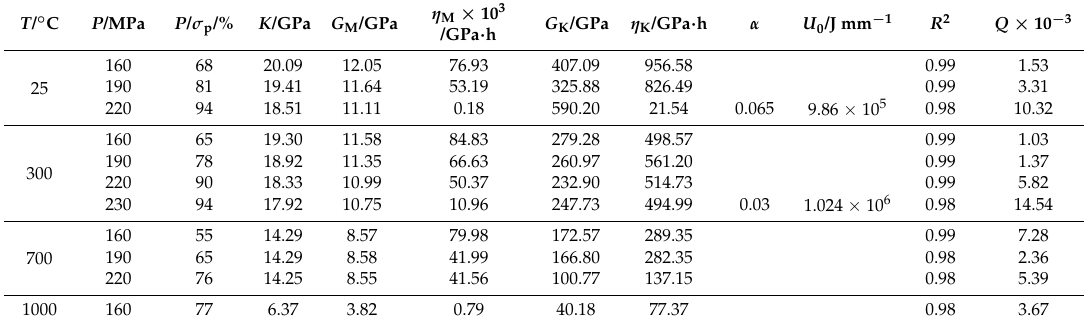
Table 2. Parameters of creep damage model in creep tests ( σ 3 = 25 MPa).